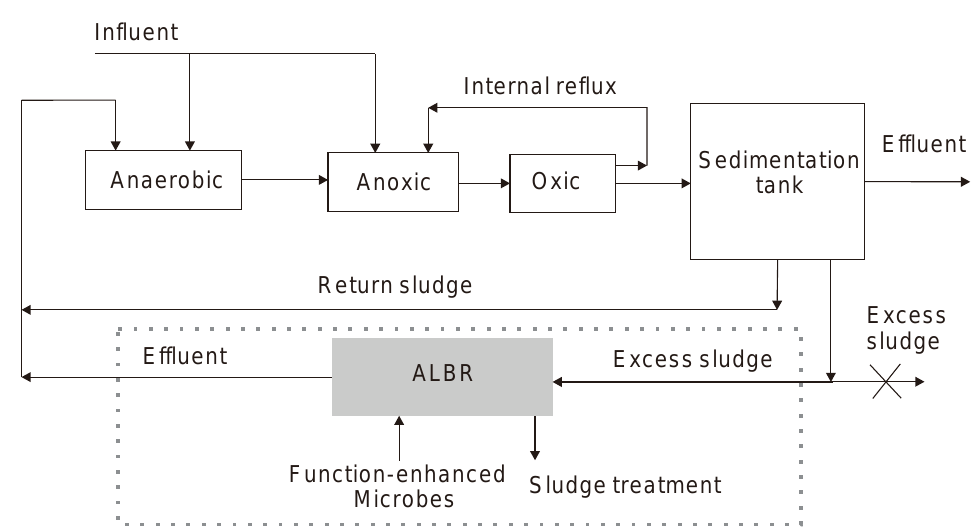
Figure 8. Treatment flow chart of refinery wastewater process optimization.